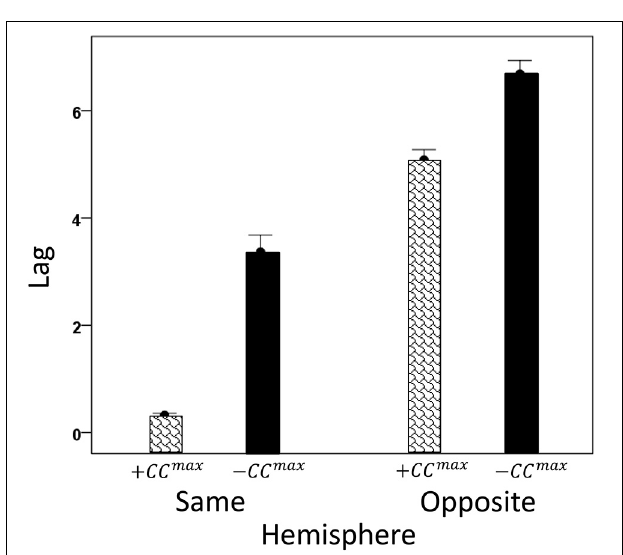
FIGURE 8 | Mean lags ( ± s.e.m.) of hemisphere recordings (see text for details).